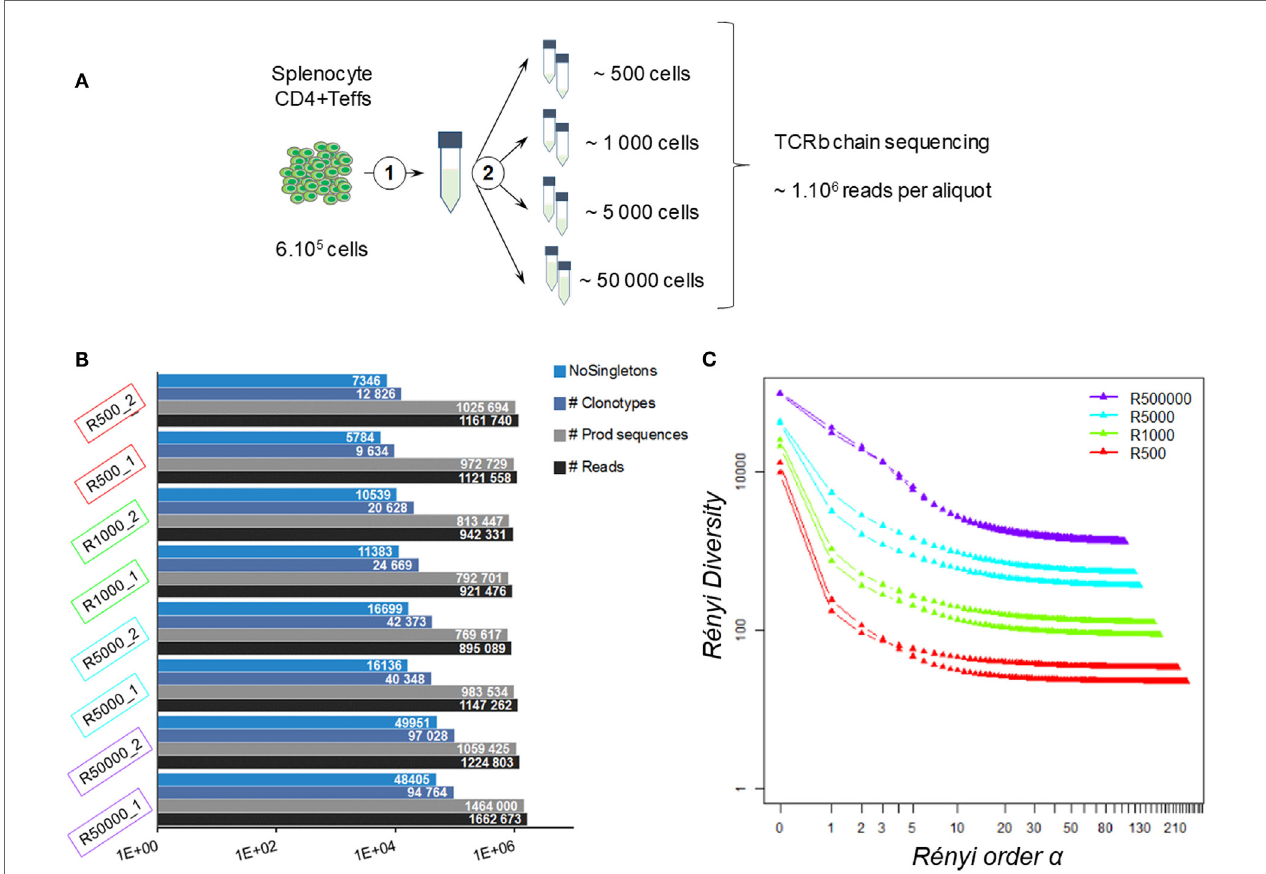
FigUre 1 | Impact of sequencing depth on measured diversity. (a) Experimental design: 600,000 CD4 + Foxp3-GFP − cells were sorted from female Balb/C Foxp3 splenocytes. RNA was extracted (1) and split into aliquots equivalent to the amount of mRNA of 500, 1,000, 5,000, and 50,000 cells (2). Two aliquots were produced for each amount of RNA. The eight prepared aliquots were processed for TRB chain deep sequencing. (B) Dataset summaries. Histograms show, for each resulting dataset, the number of reads (black), productive TRB sequences (gray), observed clonotypes (blue), and clonotypes observed more than once (NoSingletons; light blue). (c) Diversity profiles. For each dataset, a Rényi diversity profile was computed: diversity metrics using clonotype frequencies were calculated for increasing values of Rényi order α until stabilization of the resulting diversity. For α = 1, the Shannon entropy was